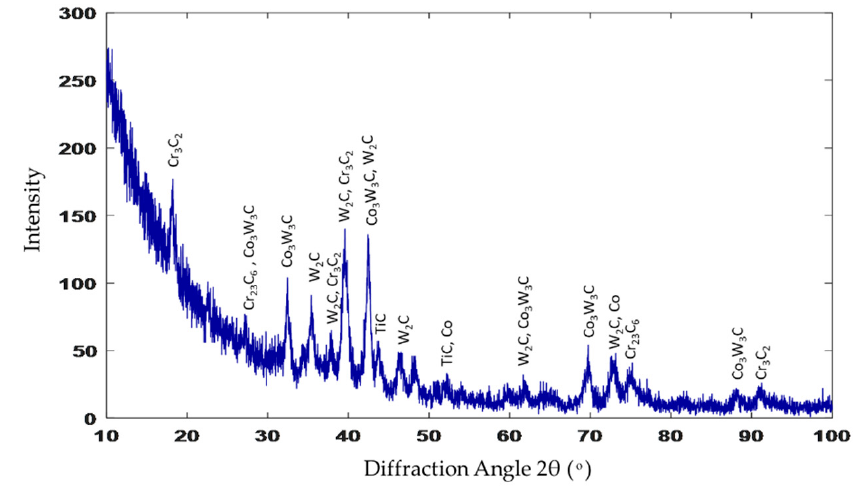
Figure 17. XRD spectrum of sample 3.